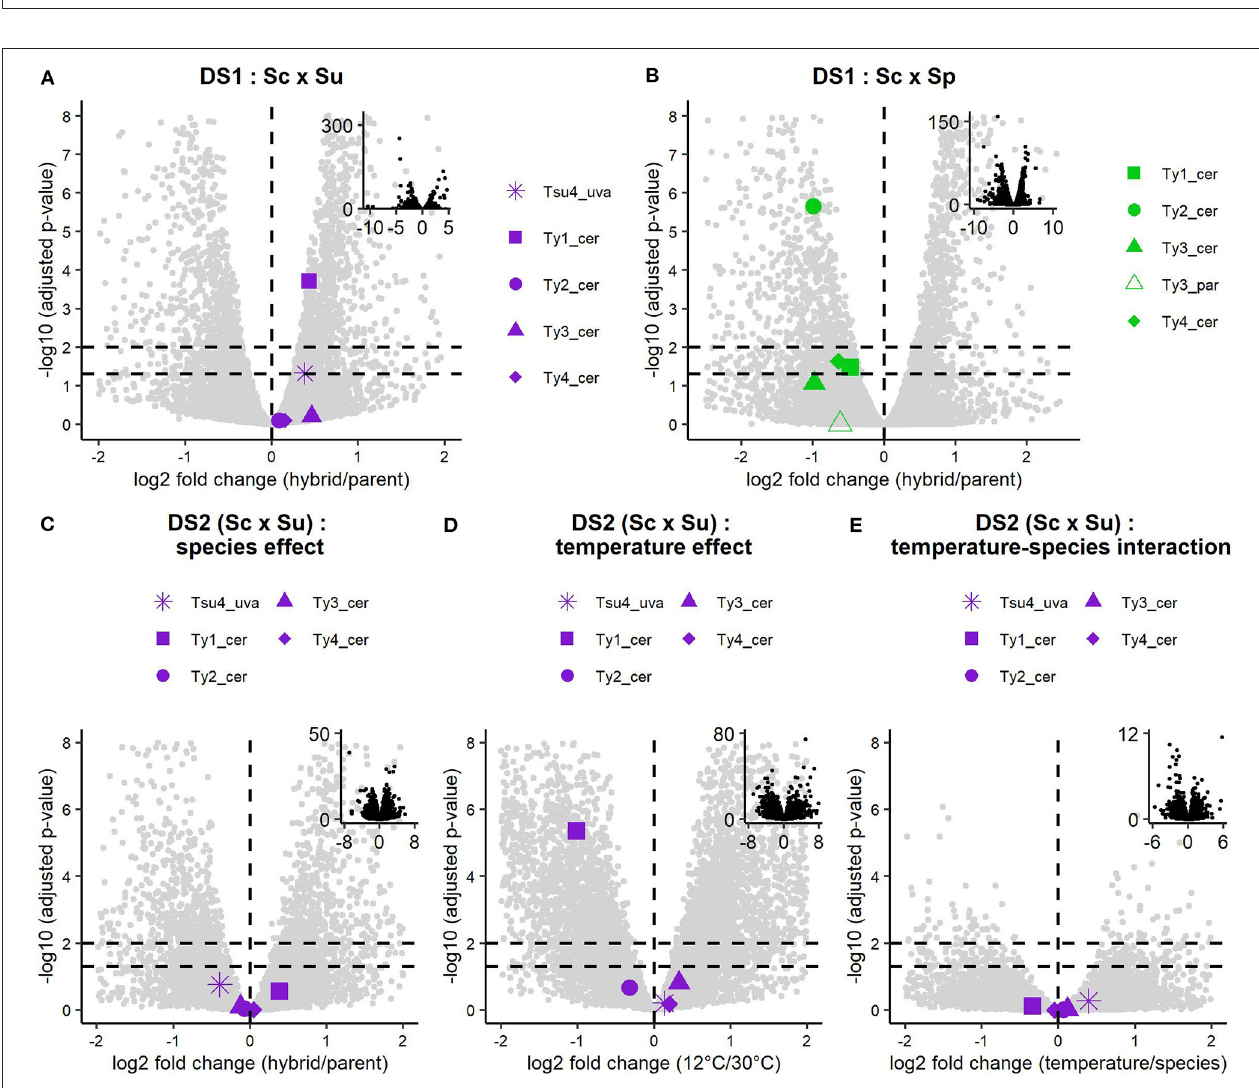
FIGURE 2 | three replicates for each parental species and hybrids at the two temperatures. For each Ty family, crosses for which one of the parents is known to harbor this family are shown. As Ty3_par was included in the Ty analysis of S. cerevisiae in Carr et al. (2012), we also investigated its content in Sc × Su samples. Transcripts Per Million (TPM) of each sample are indicated at the right of the heatmaps. Horizontal bars below the heatmaps represent the annotation of the reference sequences used for read mapping, with internal sequences and LTRs shown, respectively, in light and dark grey. The POL and GAG (except for Ty5_par) ORFs are shown as arrows.